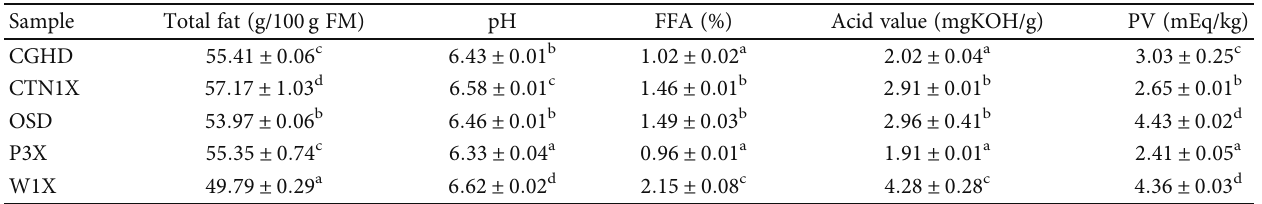
Table 3: Physicochemical features of the dried cocoa bean samples from the fi ve dryers.